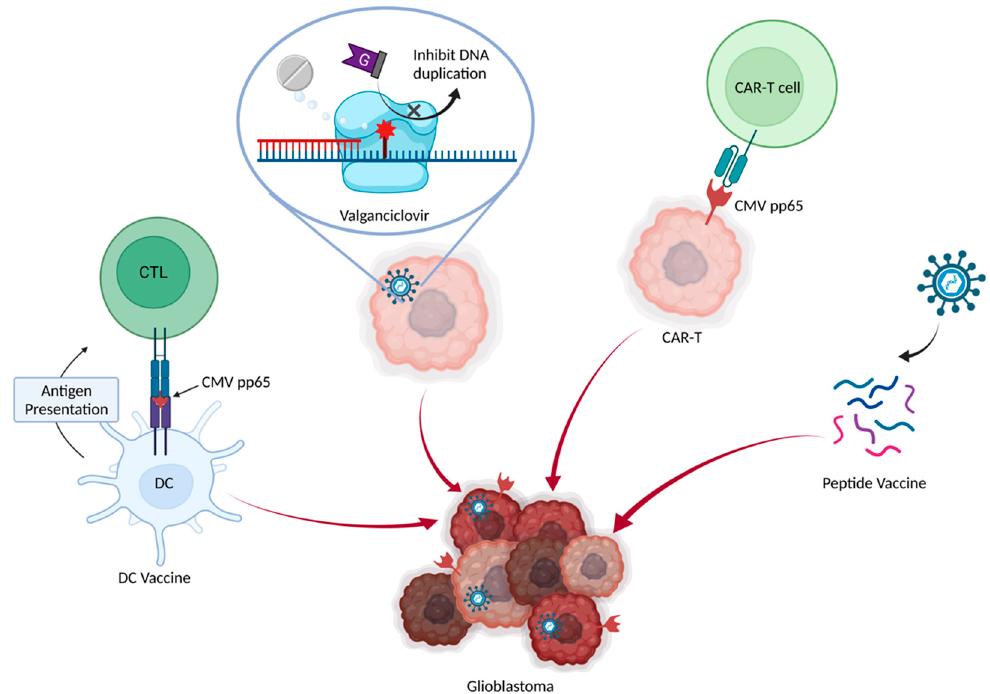
Figure 2. Various pathways of CMV-related treatment of glioblastoma. There are four major treatment methods targeting CMV. Valganciclovir is an anti-CMV drug, which also shows potential survival benefits for GBM. Immune therapy can exploit the CMV pp65 antigen as a specific target for the tumor cells. CAR-T cells can be engineered to target the CMV pp65 antigen, directly killing the tumor. Dendritic cells primed by the CMV pp65 antigen serve as a dendritic cell vaccine to recruit the cytotoxic T lymphocytes. CMV can also be used to create peptide vaccines. CMV, cytomegalovirus; DC, dendritic cell; CAR-T chimeric antigen receptor T cell; CTL, cytotoxic T lymphocyte.